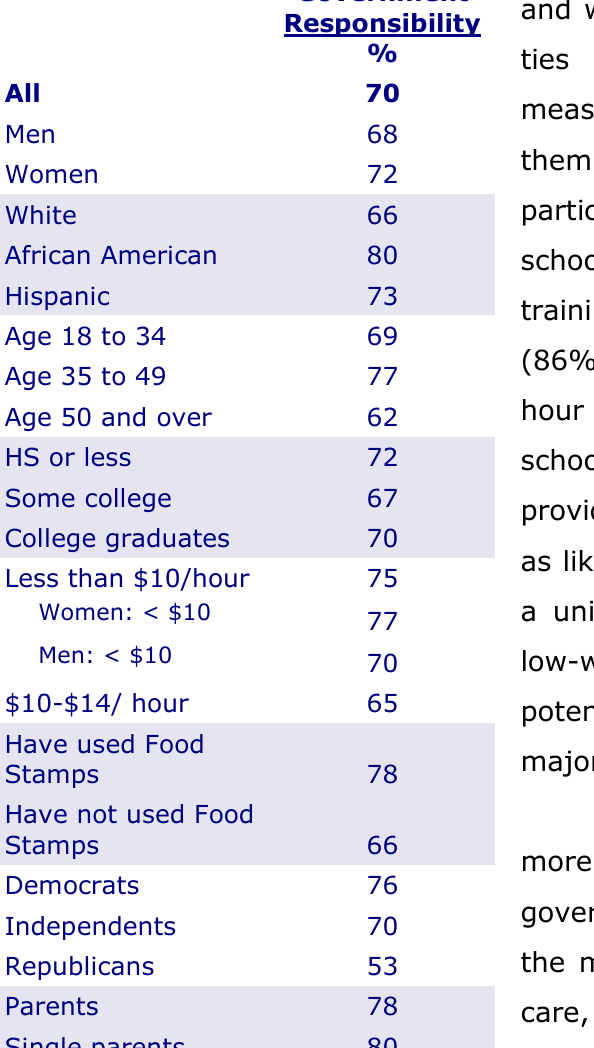
Table 9: Ensuring Everyone Has Enough to Eat